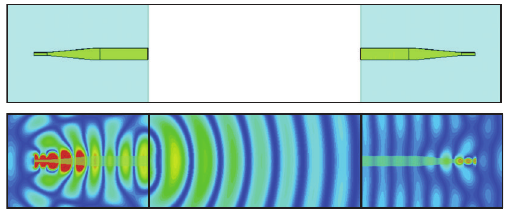
Figure 9: Optical wireless link between nanoantennas embedded in glass substrate and corresponding radiated E-field. Distance between nanoantennas is 4 µ m, frequency is 300 THz, and propa- gation medium is free space.